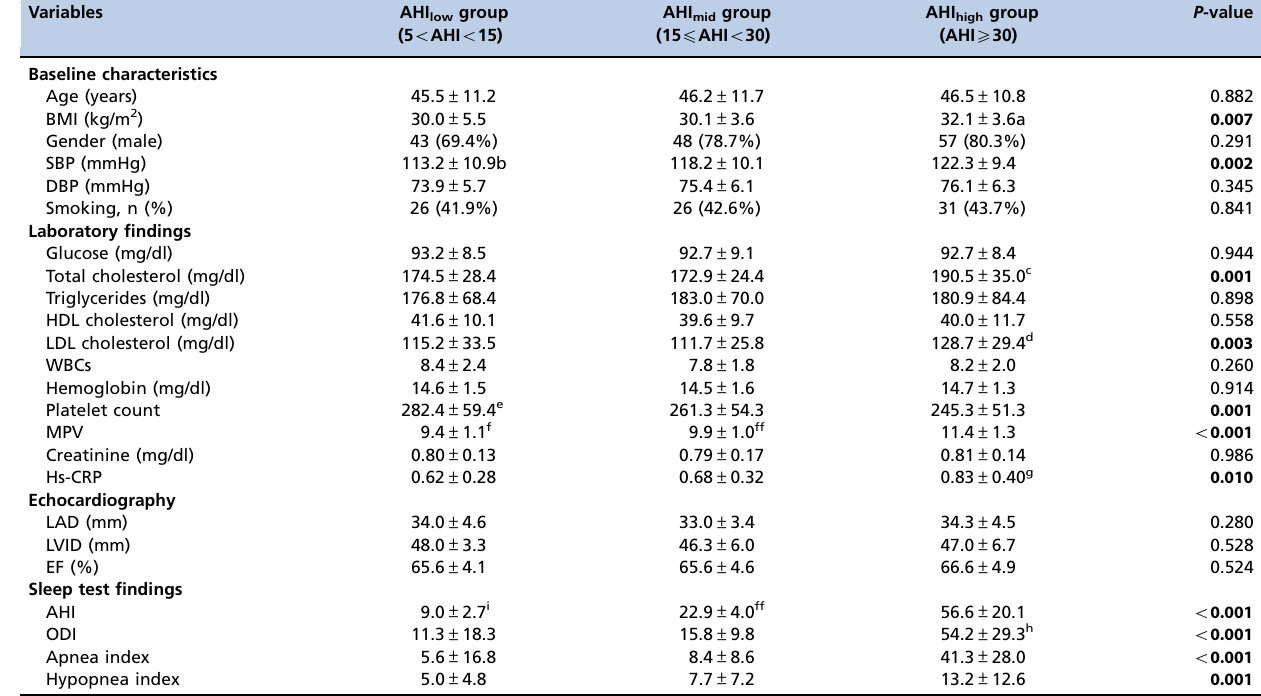
Table 1 - Baseline characteristics and laboratory, echocardiographic and sleep test findings.